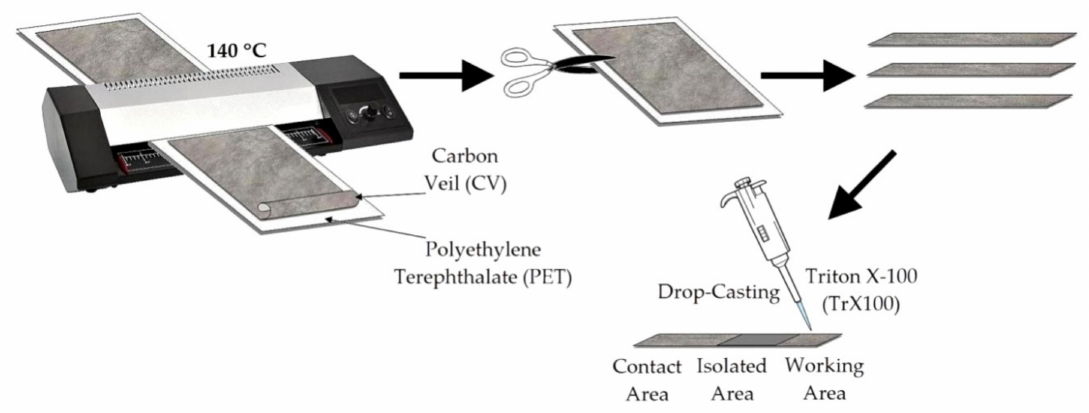
Figure 1. Manufacturing of the film carbon veil-based electrode